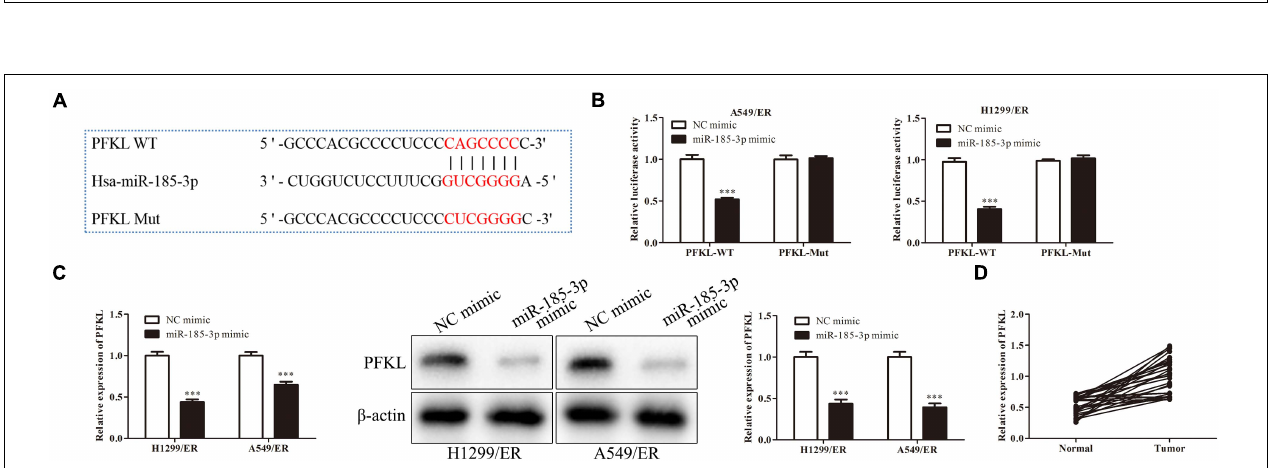
FIGURE 3 | MiR-185-3p targets liver-type phosphofructokinase (PFKL) and downregulates its expression. (A) The bioinformatics analysis of miR-185-3p and PFKL. (B) MiR-185-3p mimic targeting PFKL was determined by dual luciferase reporter assay. (C) The level of PFKL in H1299/ER and A549/ER cells was detected by Western blot. (D) Spearman’s correlation analysis assessed the PFKL expression in normal and tumor tissues. Data were shown as mean ± SD. ∗∗∗ p < 0.001.